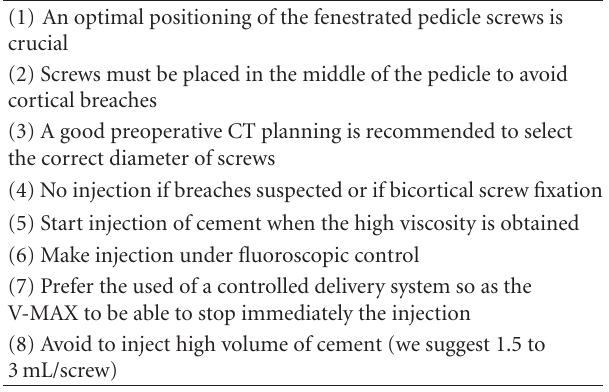
Table 3: Tips suggested to prevent PMMA cement